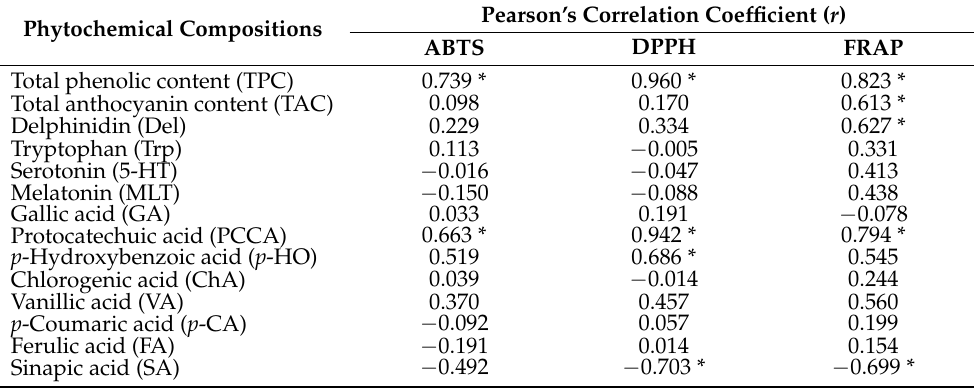
Table 4. Pearson’s correlation coefficient ( r ) values of phytochemical compositions and antioxidant capacities (ABTS, DPPH and FRAP) of different extracts obtained from purple corn and butterfly